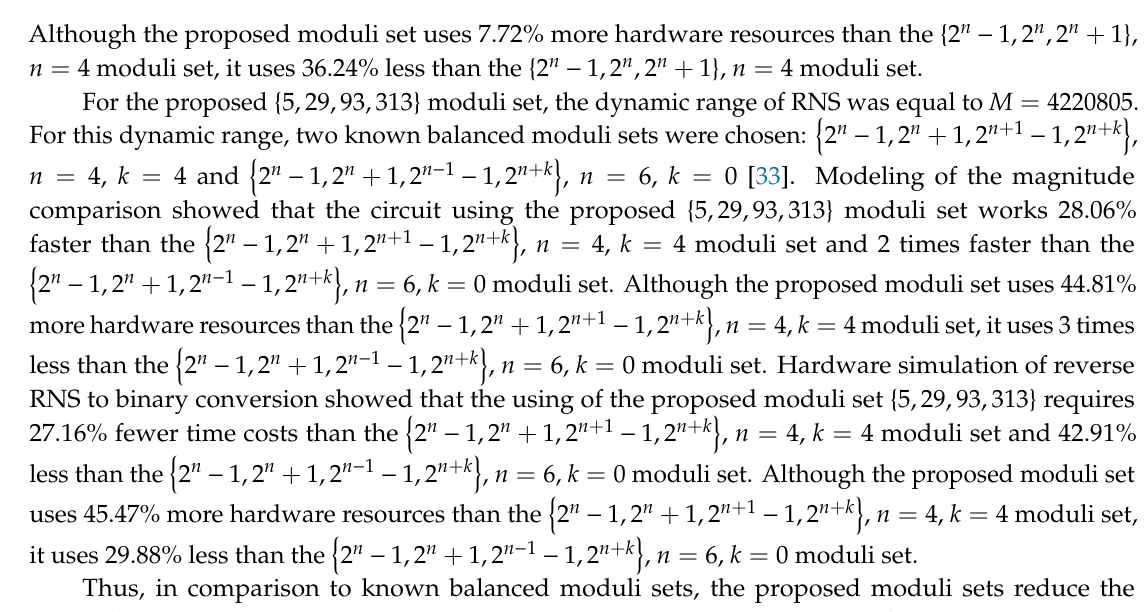
Table 5. The possibility of RNS constructing with a given sum of quotients (SQ) form. Type and Number of RNS Moduli